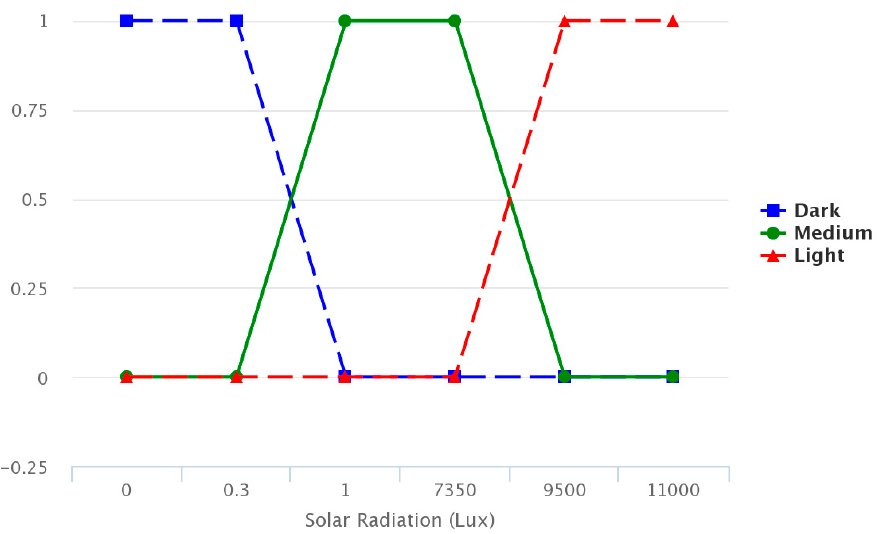
Figure 9. Solar radiation inference rule.